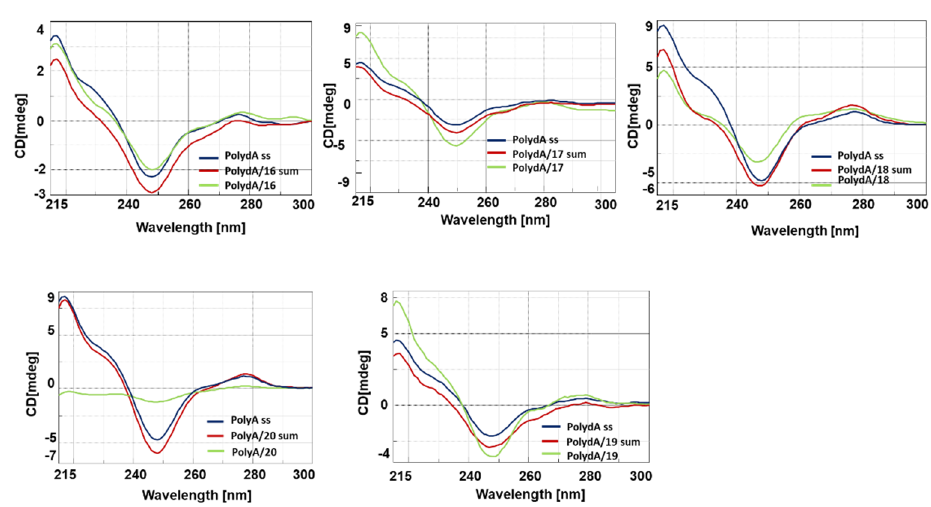
Figure 3. CD spectra of 16 - 20 /PolydA hybrids.